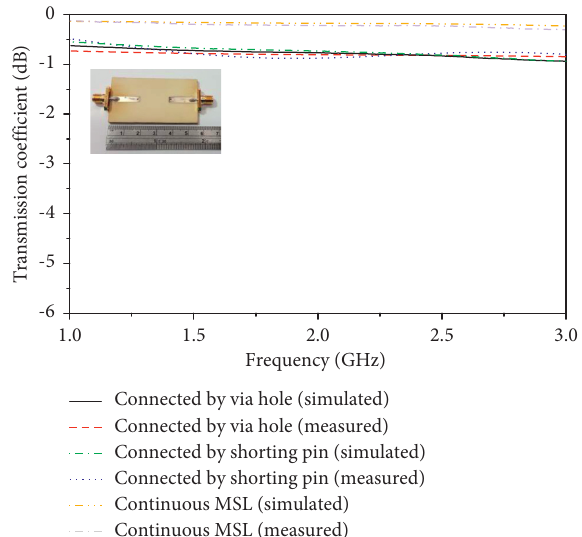
Figure 3: Transmission coefficient resulting from microstrip lines connected using the proposed via hole, shorting pin, and intact